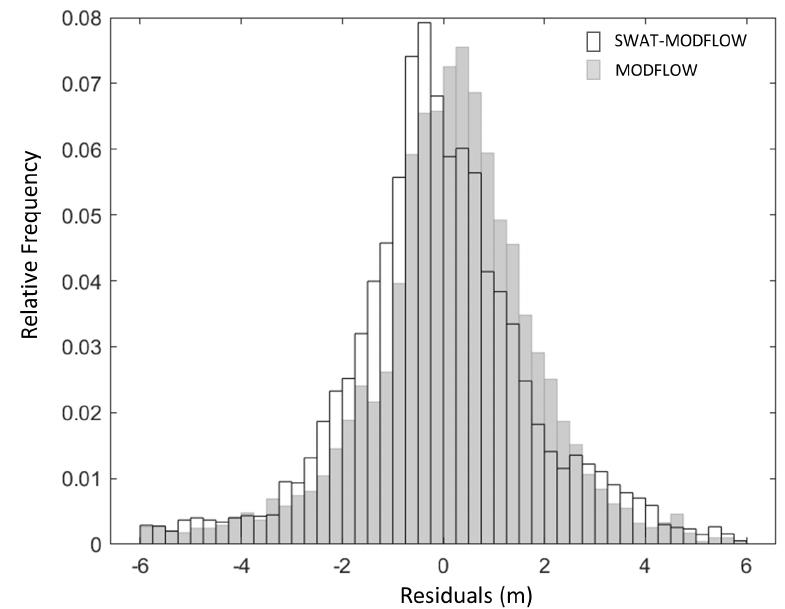
Figure 9. Residuals of simulated groundwater elevation head for the SWAT-MODFLOW model and the MODFLOW